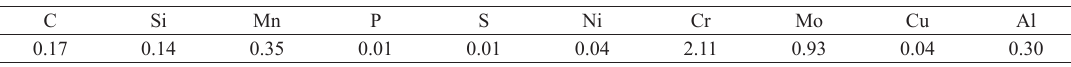
Table 1. Chemical composition (in weight percent), of ASTM A182 F22 steel.